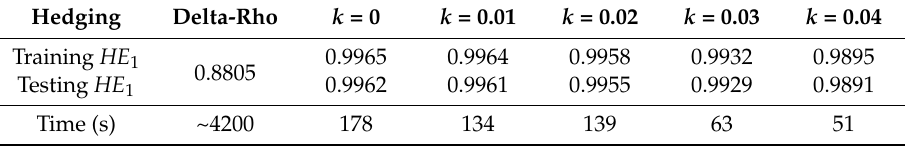
Table 3. Hedging metrics for different hedging strategies and error functions for GMDB.